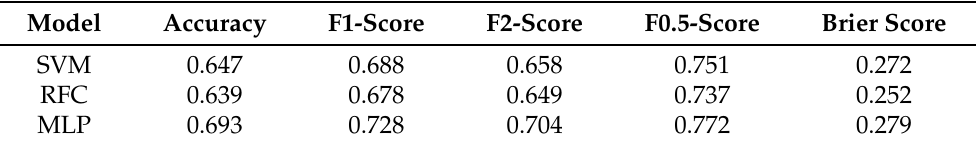
Table 6. Comparisons of the evaluation metrics of the three binary classification ML models for the averaged swath